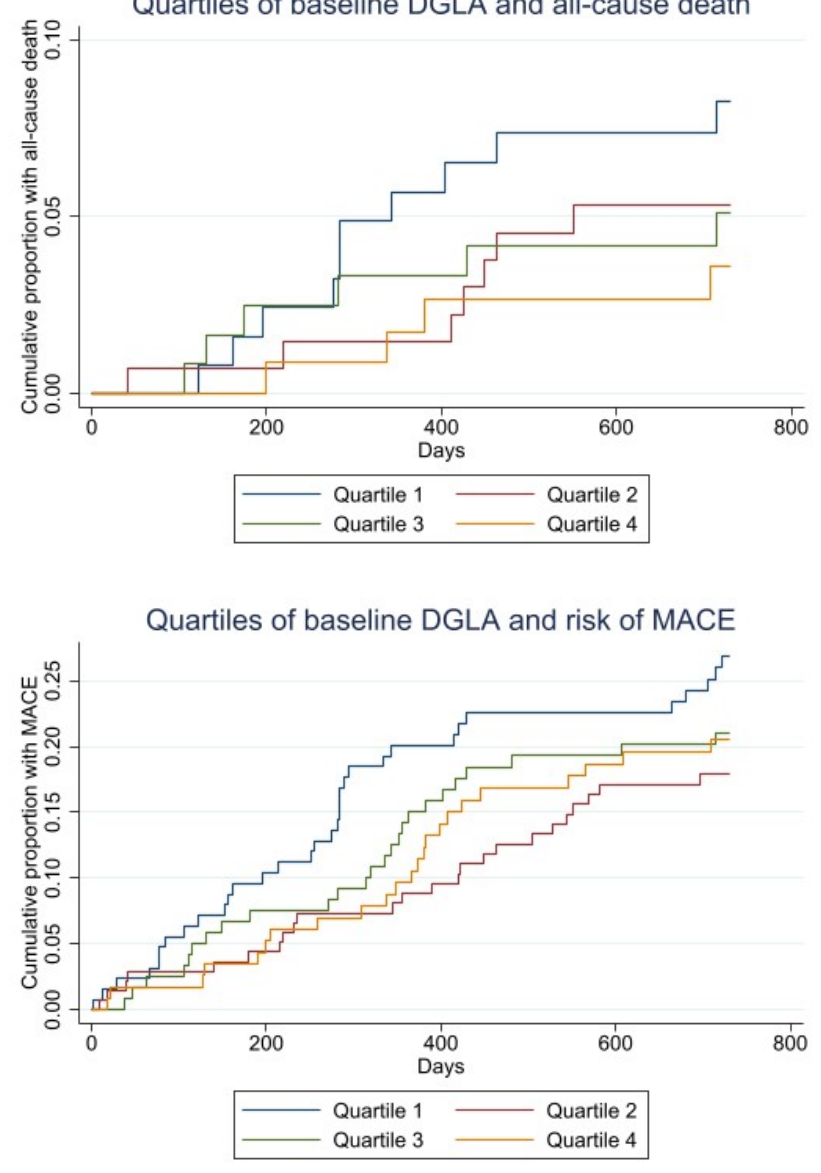
Figure 2. Kaplan–Meier curves for baseline quartiles of DGLA and all-cause death (upper). Kaplan– Meier curves for baseline quartiles DGLA and risk of MACE (lower). Table 5. Endpoints/adverse events by quartiles of